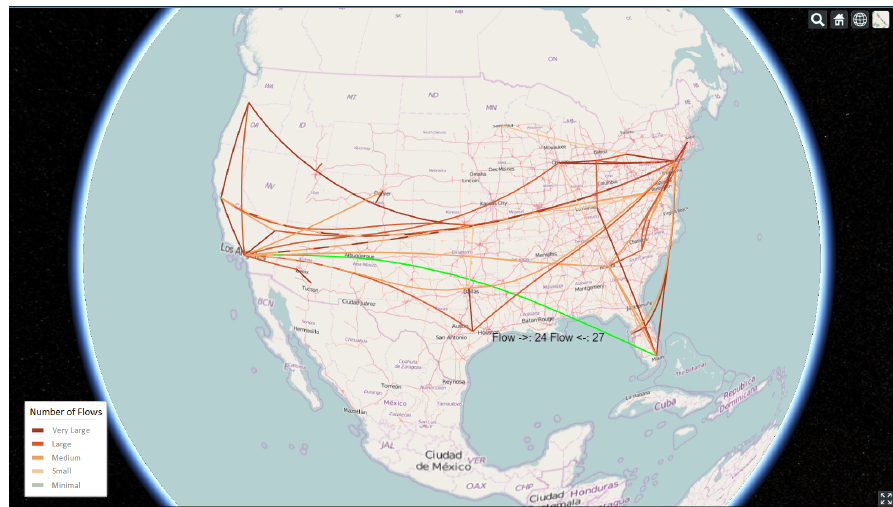
Figure 8. An overview of the 3D interactive web mapping interface.